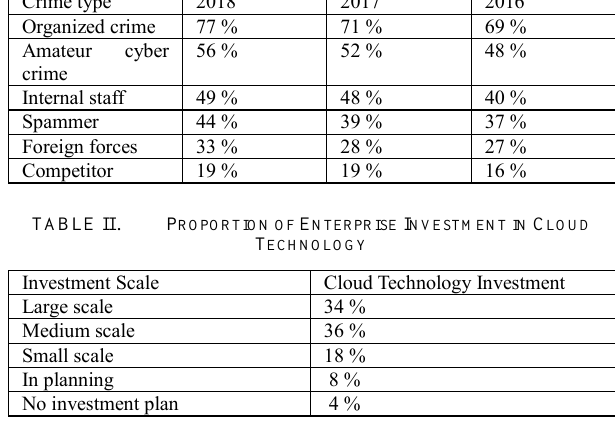
M AJOR C ONCERNS OF E NTERPRISES ABOUT C LOUD S TORAGE A PPLICATIONS (T AIWAN ) Reasons for